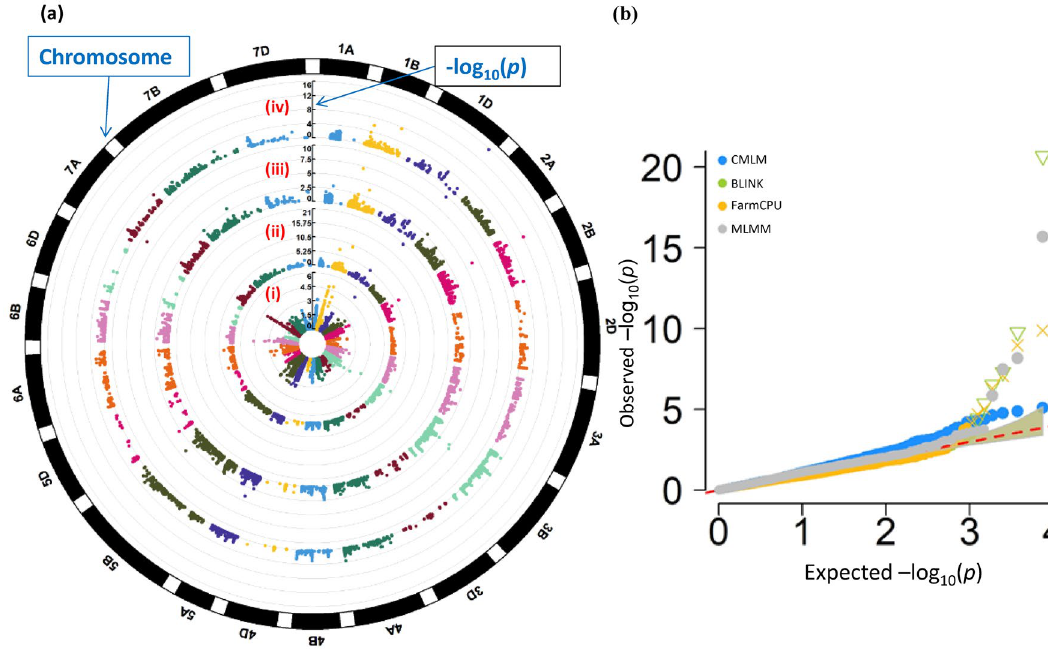
Figure 4. ( a ) Circular Manhattan plot displaying four methods of GWAS-analysis: (i) CMLM (ii) BLINK (iii) FarmCPU and (iv) MLMM. ( b ) QQ-plots of the observed and the expected p values of the GWAS models to visualize the false positives of the implemented models.